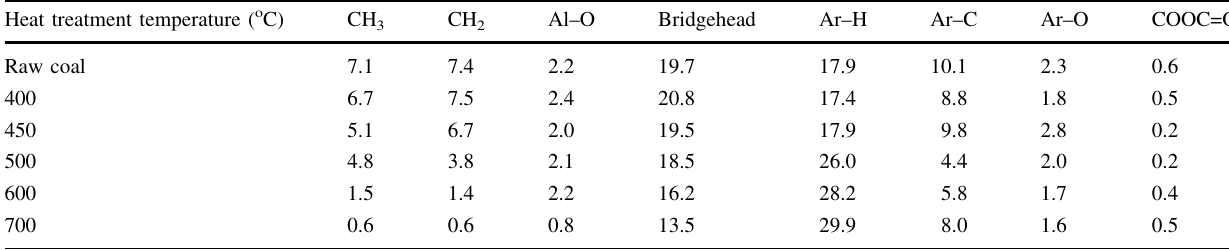
Table 3 Carbon distribution of coal NG, mmol/g-d Heat treatment temperature ( o